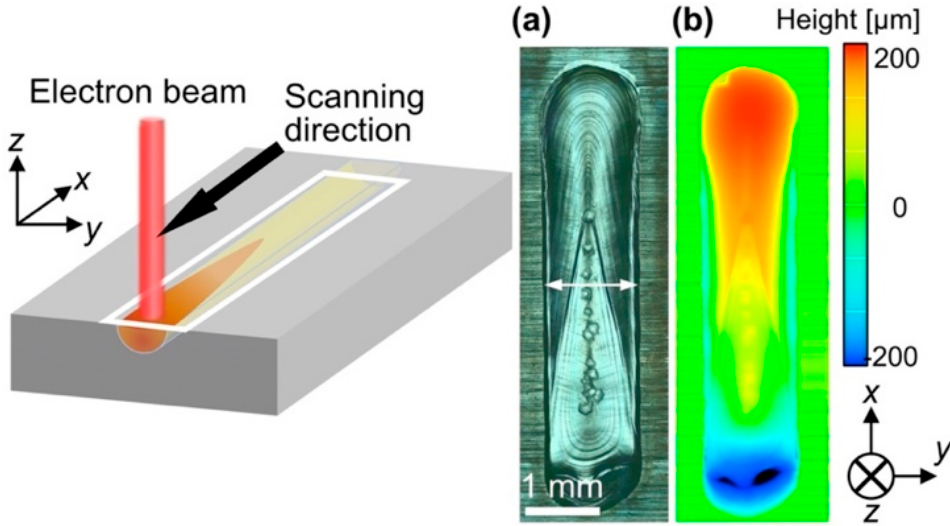
Figure 1. Typical examples of ( a ) a surface laser microscope image and ( b ) corresponding height map of 304 SS. The electron-beam power, P, and scanning speed, V, are 1200 W and 100 mm/s, respectively.